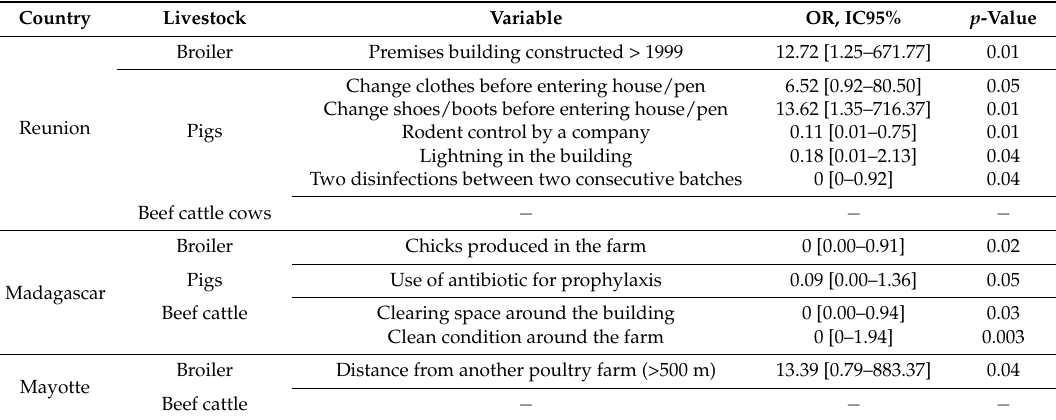
Table 5. Bivariate explanatory factors of ESBL-E occurrence in livestock from Reunion, Mayotte and Madagascar, 2016–2017.